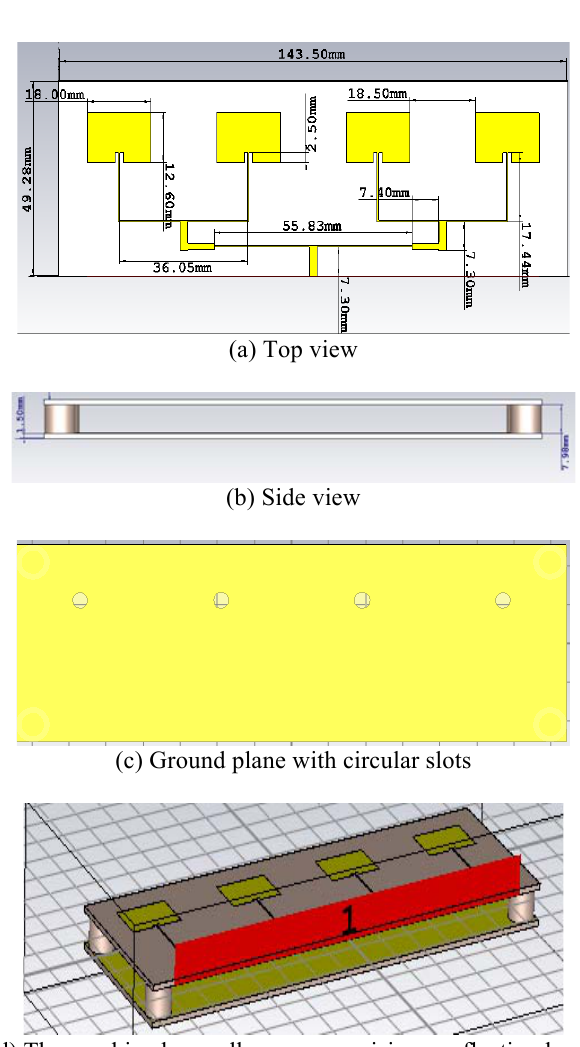
Figure 7: Geometry of the proposed array, (a) top view, (b) side view, (c) ground plane with circular slots, (d) the combined overall array comprising a reflecting